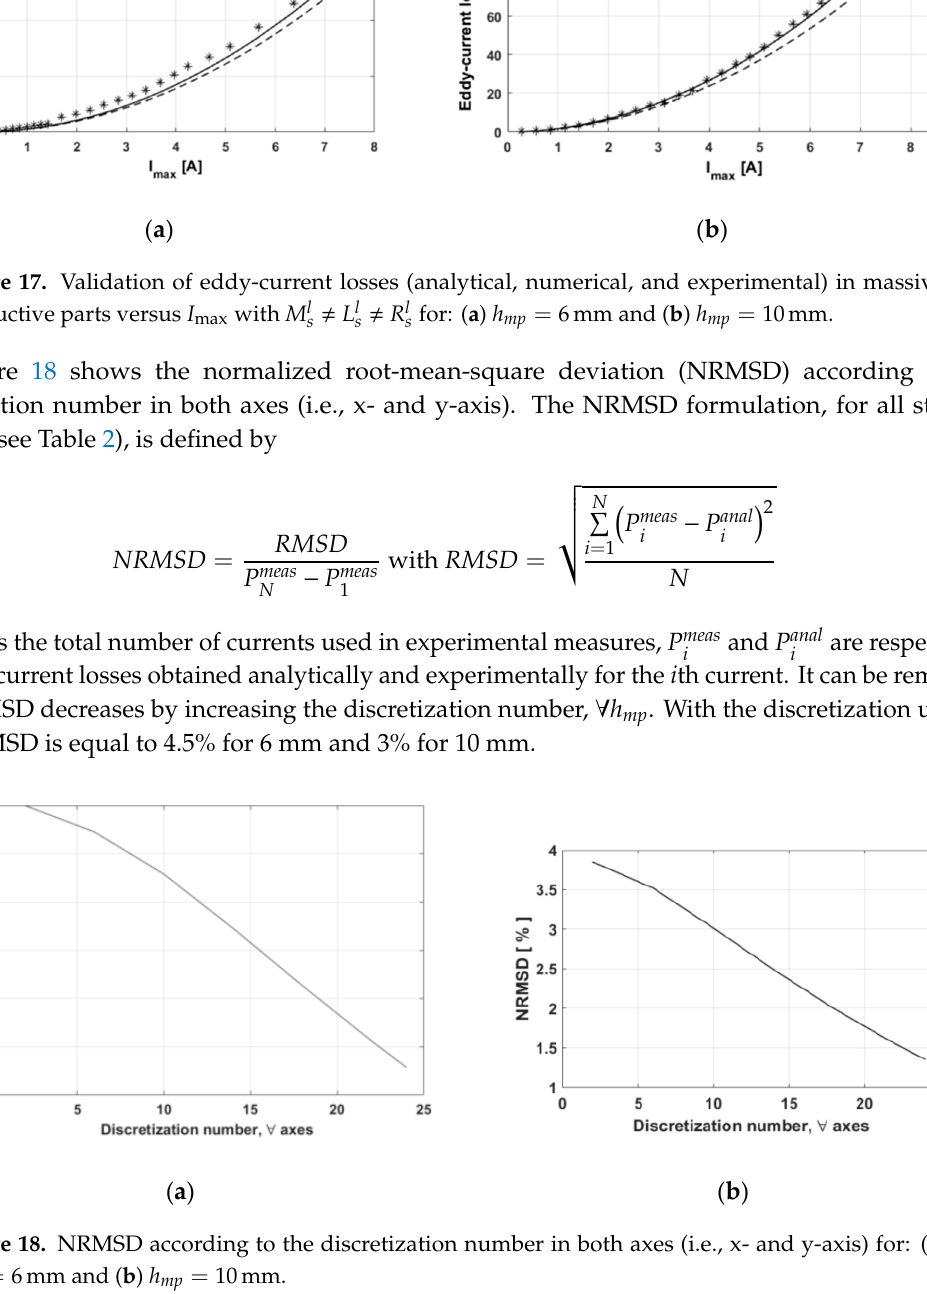
( b ) Figure 16. Validation of eddy-current losses (analytical, numerical, and experimental) in massive conductive parts versus max I